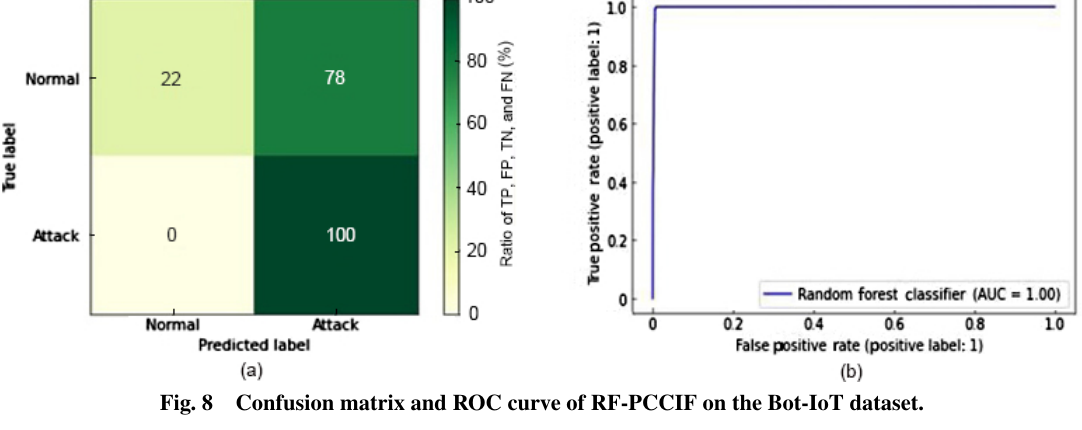
Fig. 8 Confusion matrix and ROC curve of RF-PCCIF on the Bot-IoT dataset.